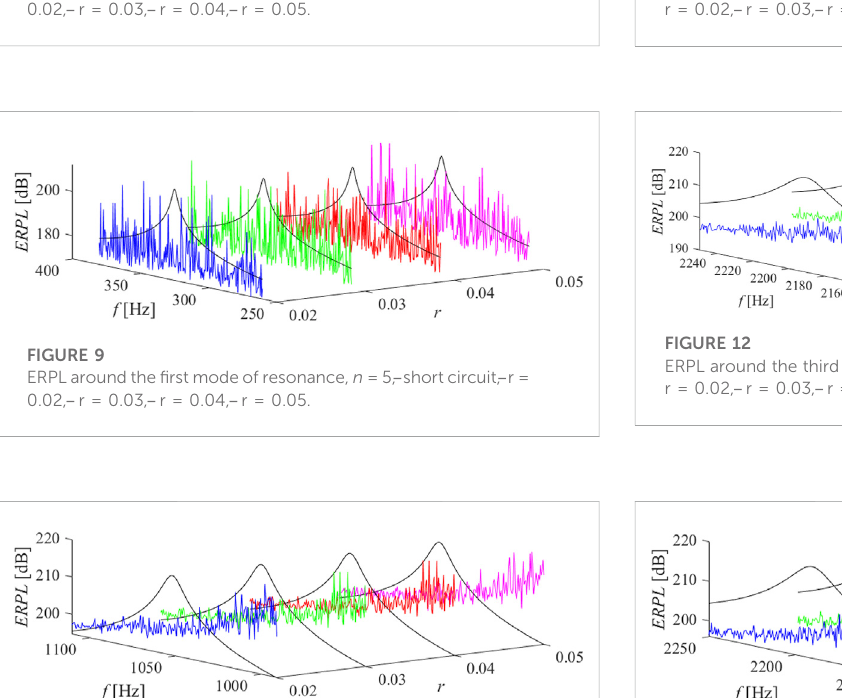
FIGURE 11 ERPLaroundthesecond modeofresonance, n =5, ̶ short circuit, ̶ r = 0.02, ̶ r = 0.03, ̶ r = 0.04, ̶ r = 0.05.